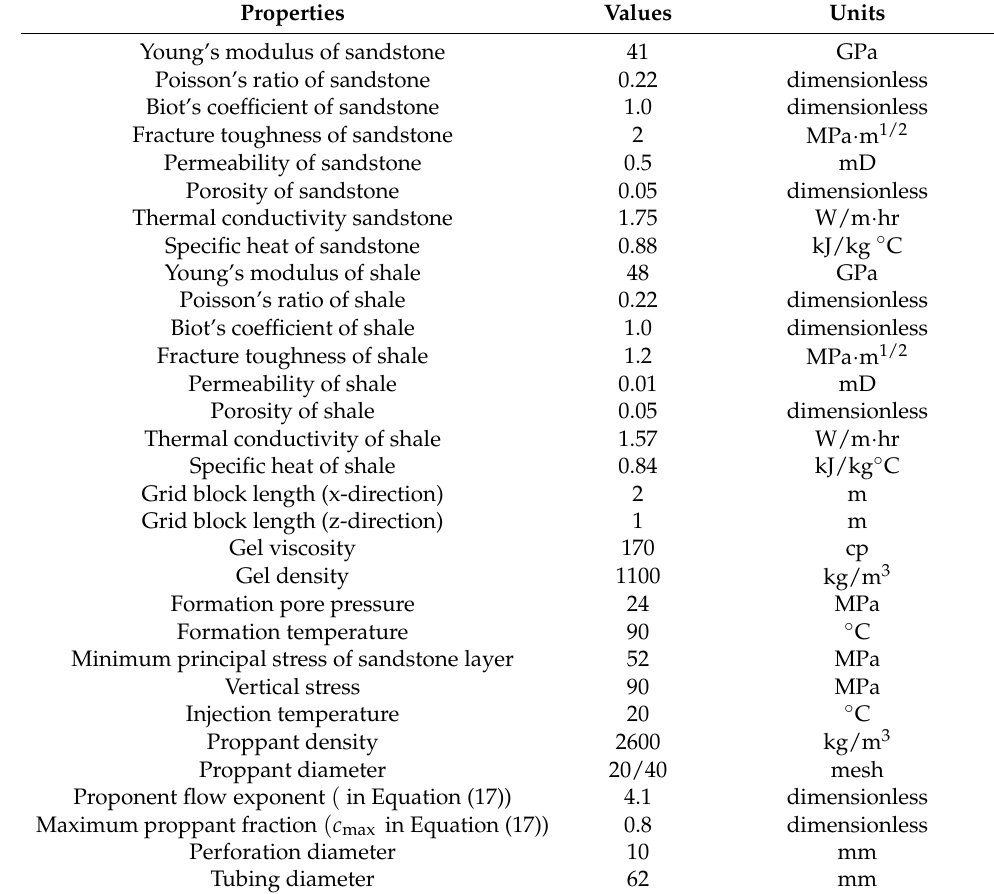
Table 5. Input parameters for the case study.